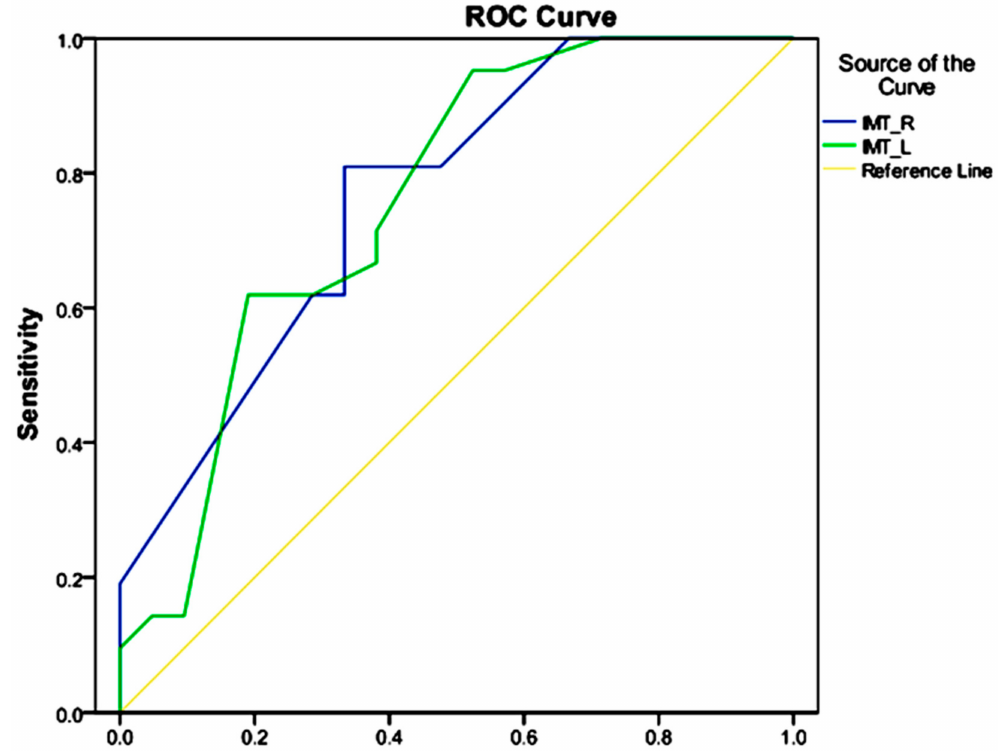
Figure 1. ROC curves for determining power of the IMT in the right and left carotid arteries in the diagnosis of